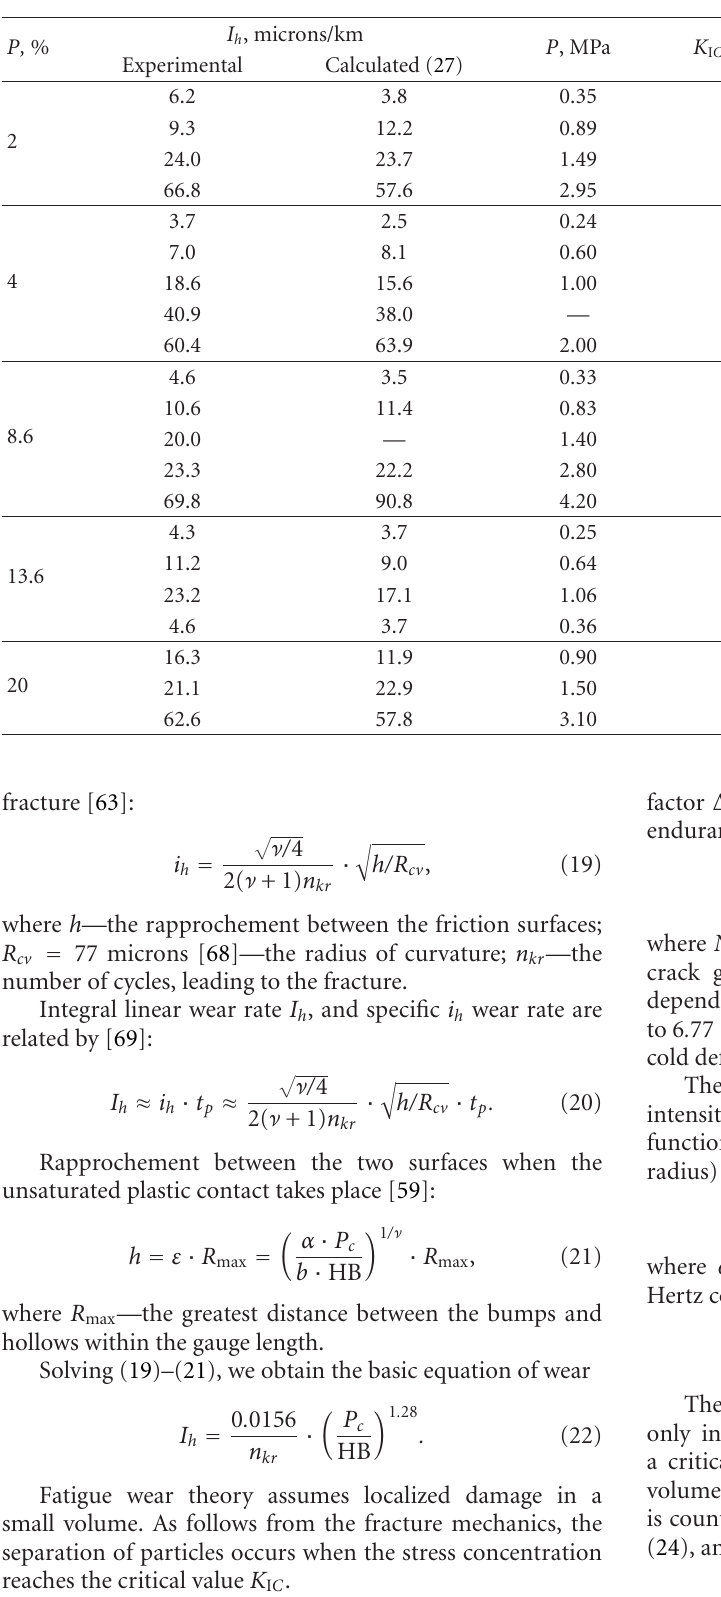
Table 4: Iron powder